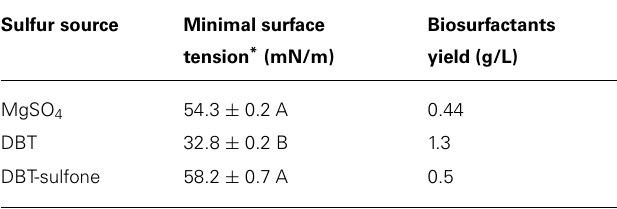
Table 2 | Characteristics of biosurfactants production byAK6U.